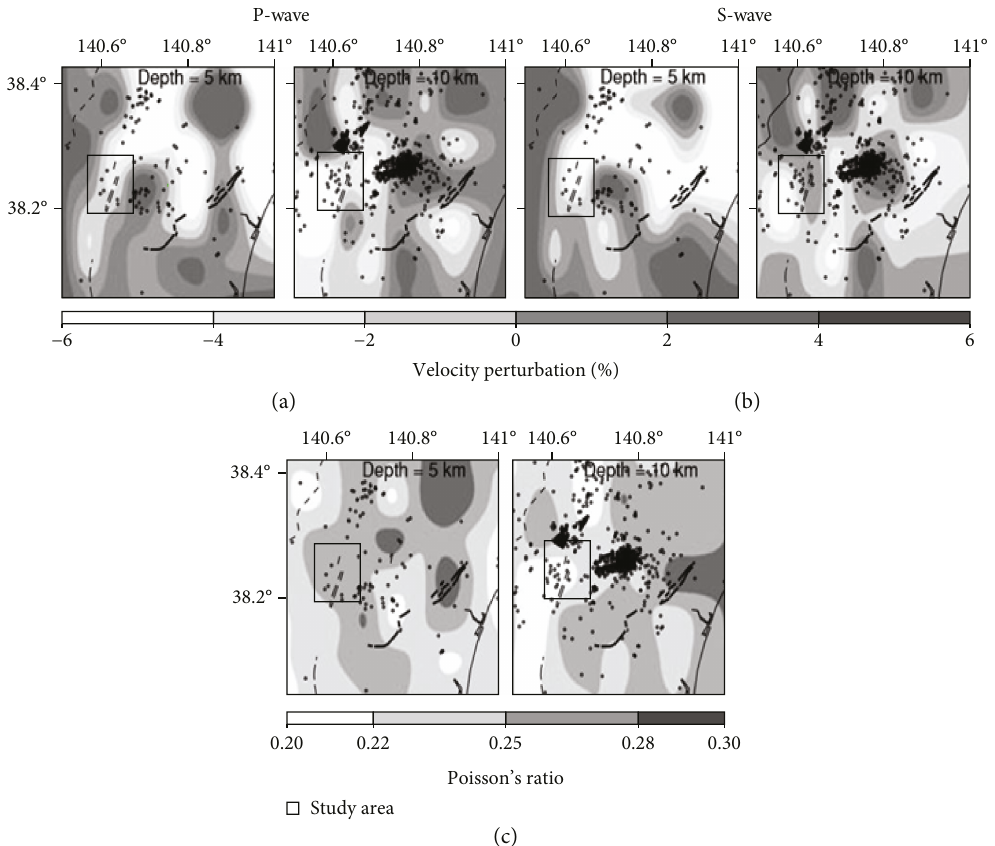
Figure 7: Seismic tomography maps showing (a) primary wave (P-wave) velocity perturbation (%), (b) secondary wave (S-wave) velocity perturbation (%), and (c) Poisson ’ s ratio, modi fi ed from Nakajima et al. [42]. A zone of low seismic velocity at depths of 5 and 10km is observed in the study area (open square), indicated by a lighter shade. This zone is suggested to indicate the vertical extent of the magma chamber, in agreement with our study. The slightly higher Poisson ’ s ratio observed at a depth of 5 km indicates the existence of melt- or H O- fi lled pores. Black dots show earthquake swarms within ± 2.5 km of the corresponding 2